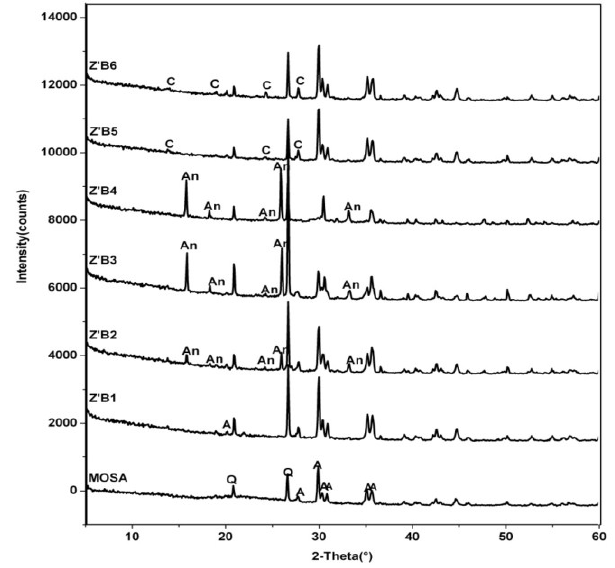
Figure 3. XRD patterns of alkali activated MOSA.